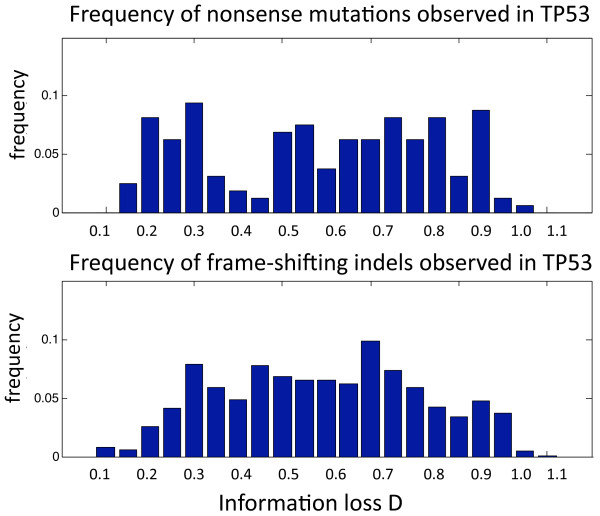
Distribution of mutations on the human tumour repressor TP53 with respect to their respective loss of information scores. The upper panel shows the distribution of D for 95 somatic, 49 cell-line and 15 germline NM in the TP53 tumour suppressor. The lower panel show the distribution of D for 1256 somatic, 127 cell-line and 36 germline FS indels reported for TP53 protein. These mutations are associated with a wide range of cancers.